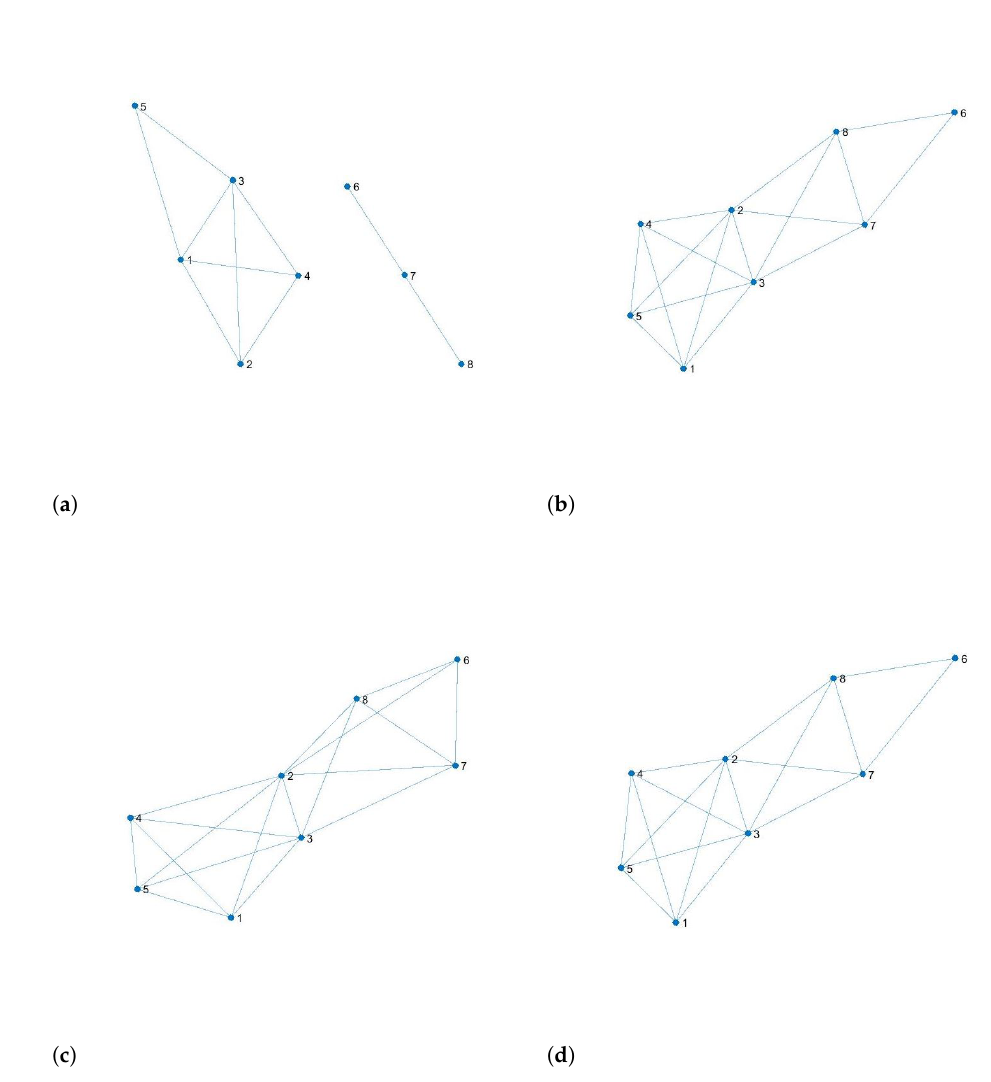
Figure 7. The simulated graphs G S ( δ ) with δ = 0.5 for N = 8 assets. ( a ) The graph G S ( δ ) resulting from the BEKK model; ( b ) the graph G S ( δ ) resulting from the modified BEKK model; ( c ) the graph G S ( δ ) resulting from the DCC model; ( d ) the graph G S ( δ ) resulting from the modified DCC model. Vertex number refers to the associated asset. Table 4. The correlation matrix for N = 8